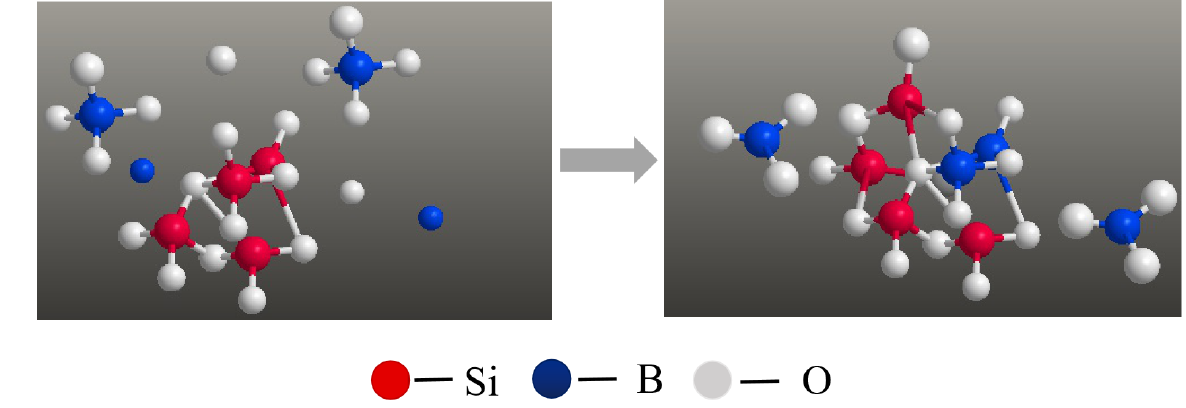
Figure 8: Process diagram of [BO 4 ] combined with silicon-oxygen network